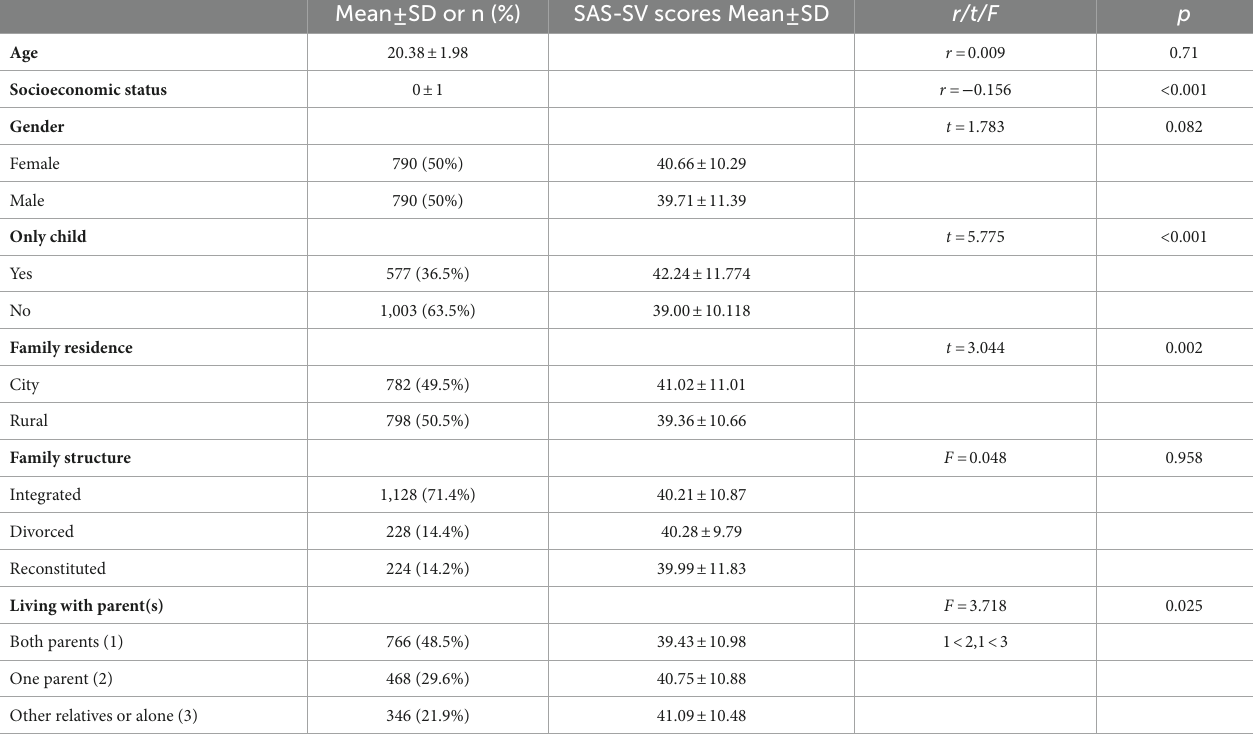
TABLE 1 Participants’ sociodemographic characteristics and smartphone addiction scores.